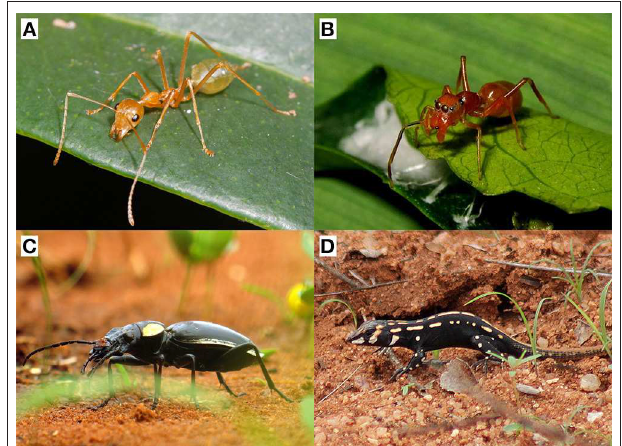
FIGURE 1 | Examples of cue mimicry in protective mimicry. The body shape of the ant Oecophylla smaragdina (A) is mimicked by the spider Myrmaplata plataleoides (B) . Note that this instance of cue mimicry may not be considered as such under the informational approach ( Table 1 ). In addition to signal mimicry, the gait of the beetle Anthia thoracica (C) is mimicked by the juvenile lizard Heliobolus lugubris (D) . Photo credits: (A) Lek Khauv; (B) Jason Alexander; (C) Tjeerd de Wit; (D) Christine